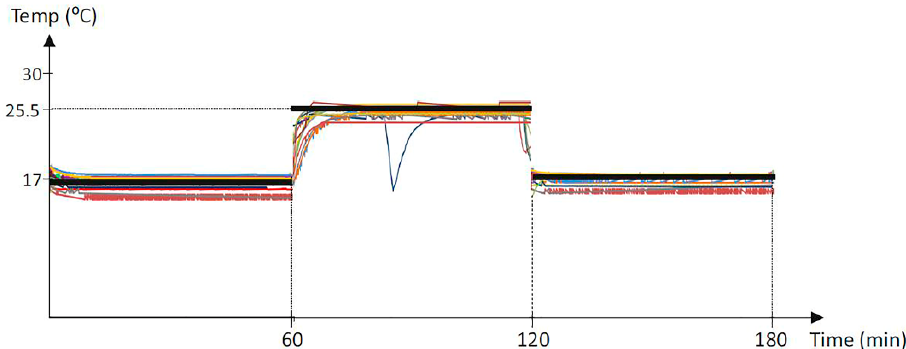
Figure 5. The results of Experiment 1.